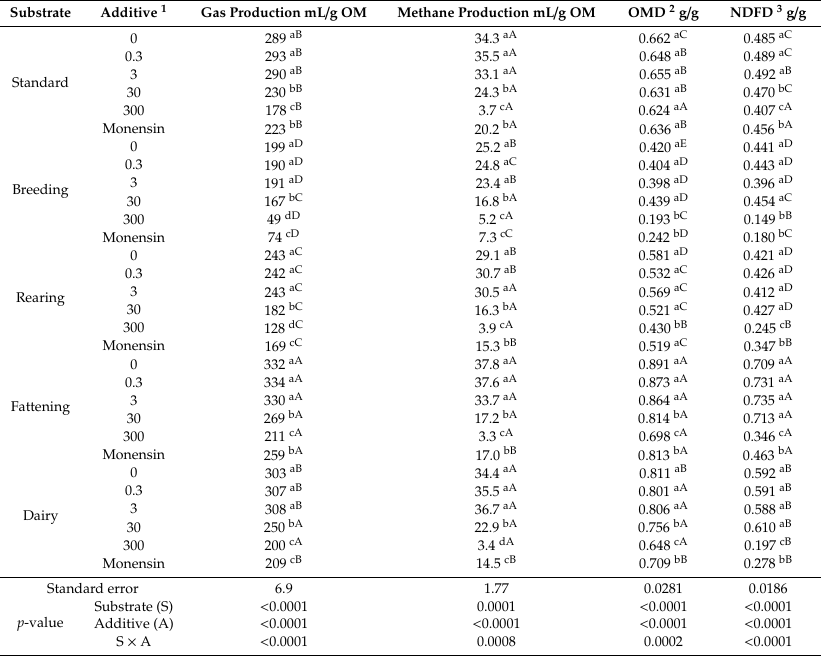
Table 2. E ff ects of increasing doses of essential oil of Lippia turbinata or monensin addition on total gas and methane production and organic matter and fiber digestibility during the in vitro fermentation of substrates, representing di ff erent livestock production system diets and a laboratory standard